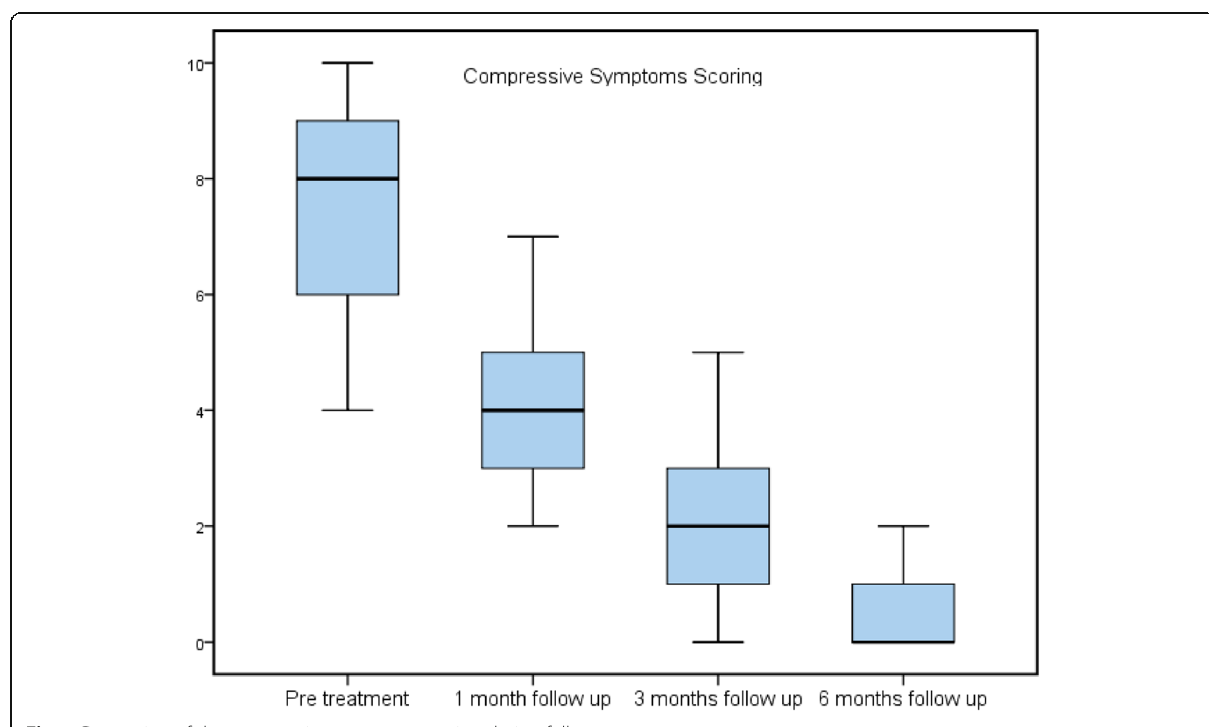
Fig. 5 Decreasing of the compressive symptoms scoring during follow-up